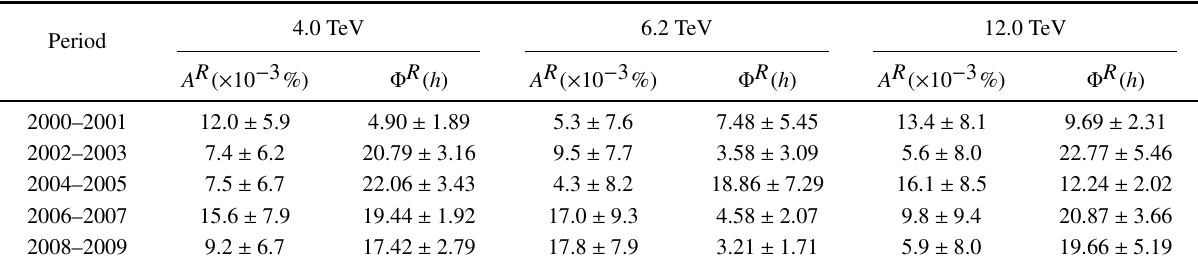
Table 2: Amplitudes and Phases of the Multi-TeV Mean Extended-sidereal Diurnal Variation Observed by Tibet in 2000–2009 Period